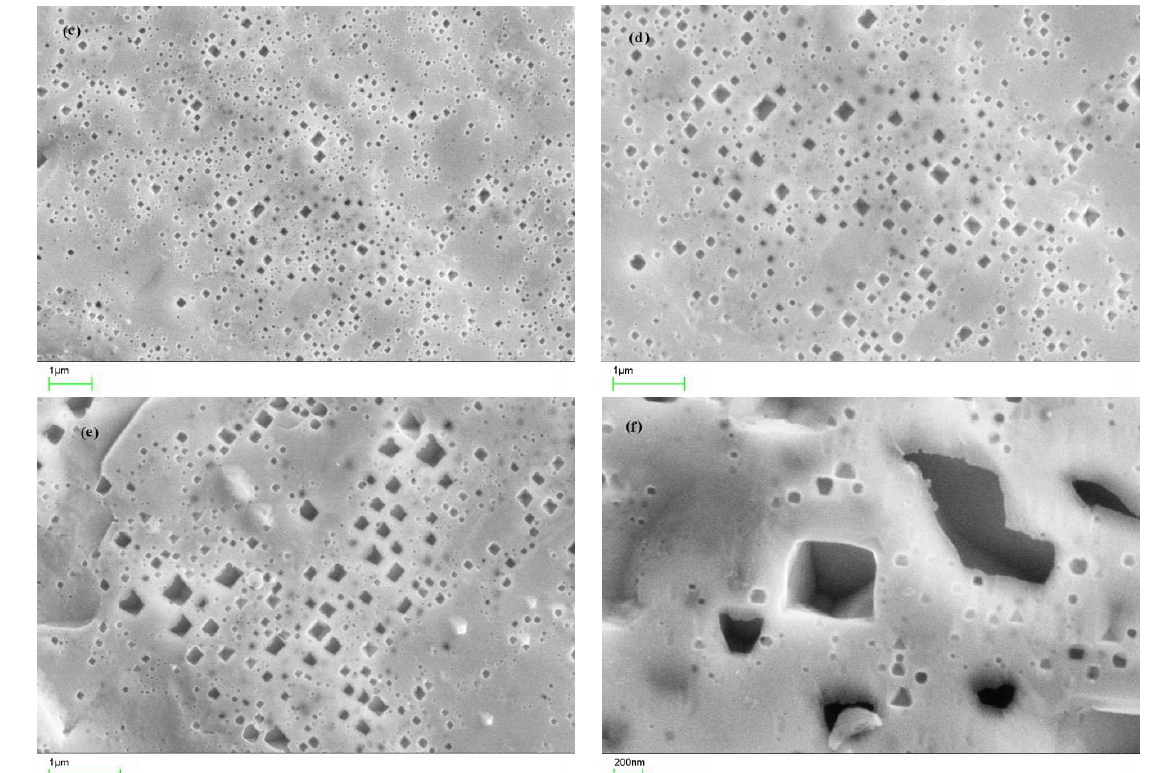
Figure 1. SEM images of the working (pc)Pt electrode of a general view ( a ) and two sections of the surface ( b – d ) and ( e , f ) with WD = 7.5 mm ( a – d ) and WD = 6.0 mm ( e , f ) at different magnifications: 1000 × ( a ); 10,000 × ( b ); 30,000 × ( c ); 50,000 × ( d , e ) and 100,000 × ( f ).